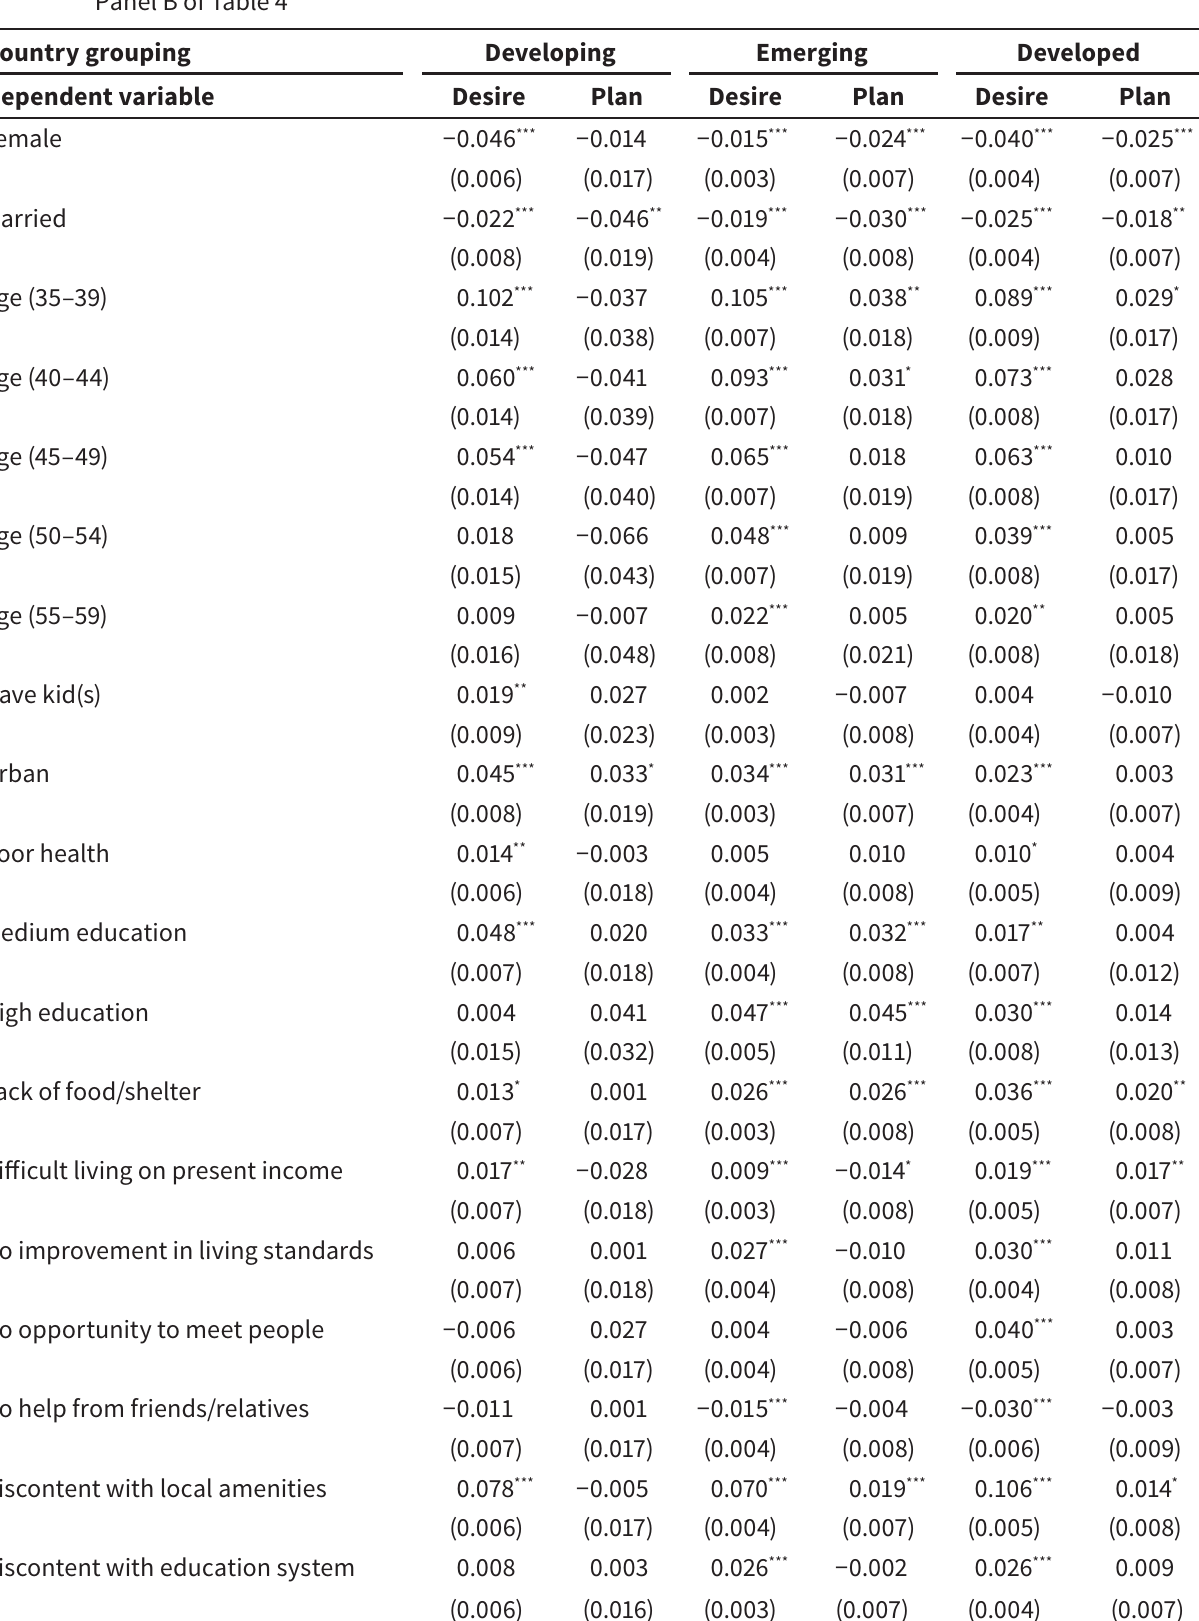
Employed adults (35–64) desire/plan to migrate abroad, full regression results corresponding